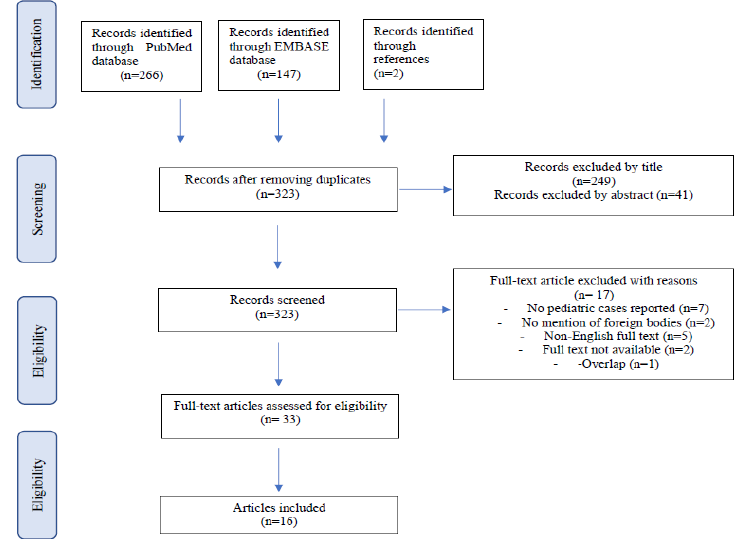
Figure 1. Review screening process.